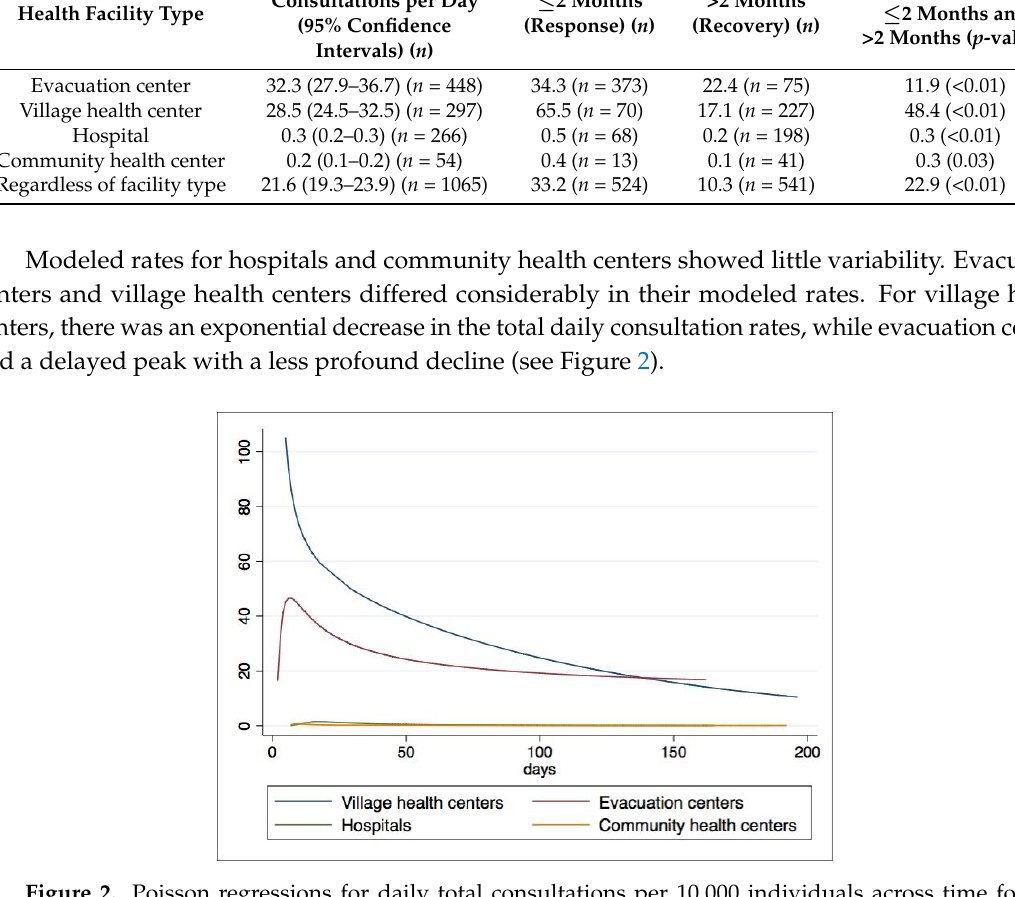
Figure 2. Poisson regressions for daily total consultations per 10,000 individuals across time for different health facility types.